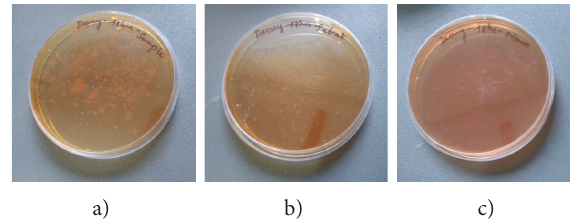
a) b) c) Plate 2. Sample treated with AgNP and AEIC of Imperata cylindrica in 12 hrs: a – Control sample; b – Treated with AEIC; c – Treated with AgNP